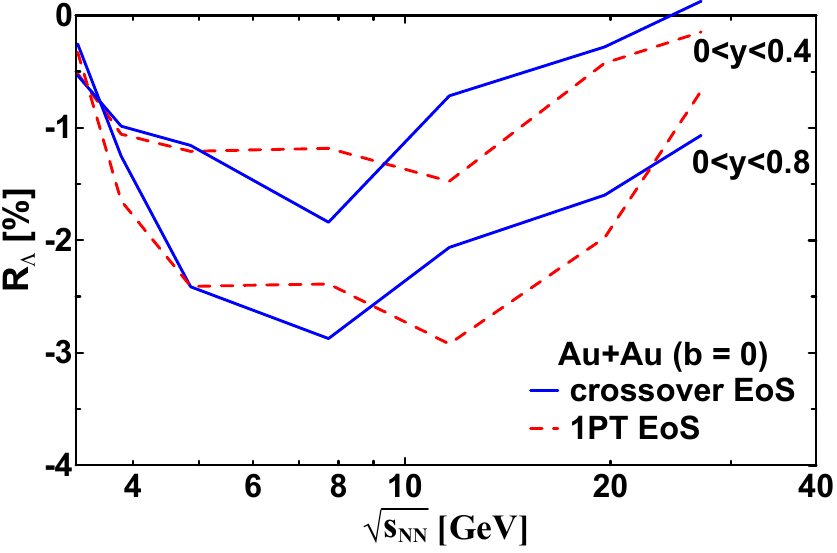
Figure 6. The R Λ quantity averaged over different rapidity ranges in the ultra-central Au+Au √ s NN . Calculations are performed with the crossover and 1PT collisions as a function of